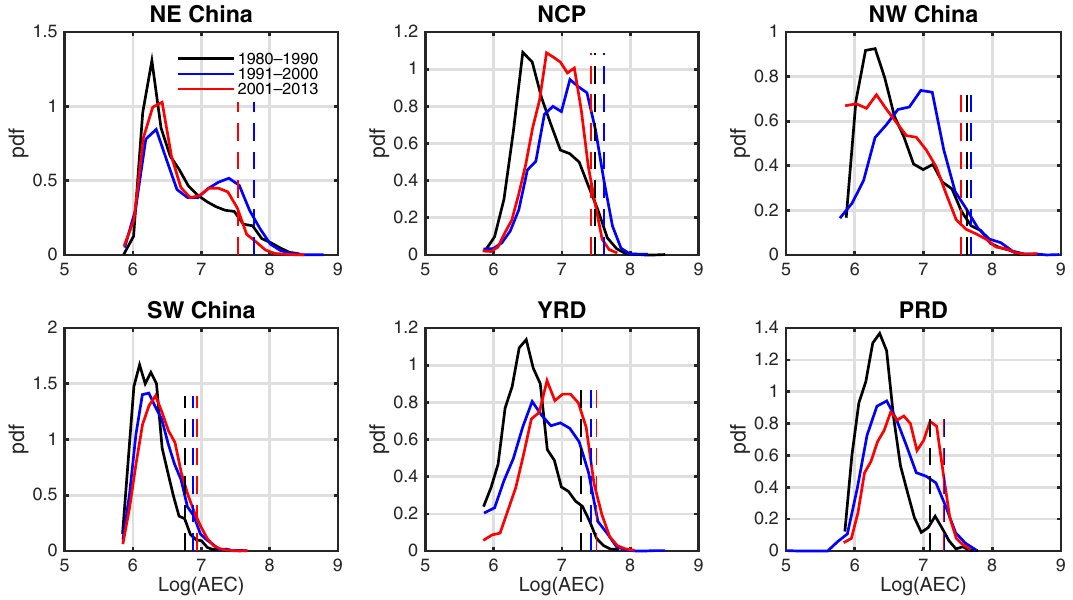
Figure 2. Probability distribution function (pdf) of AEC (Mm − 1 ) for the 3 decades over the six representative regions marked in Fig. 1b. The AEC has been converted to logarithmic